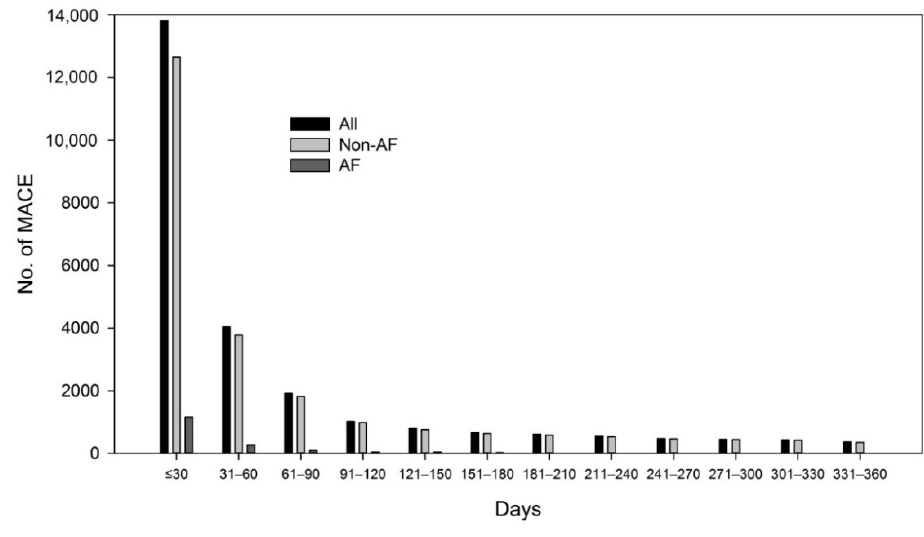
Figure 2. Time elapsed between pneumonia and development of major adverse cardiovascular events (MACE). AF, atrial fibrillation.